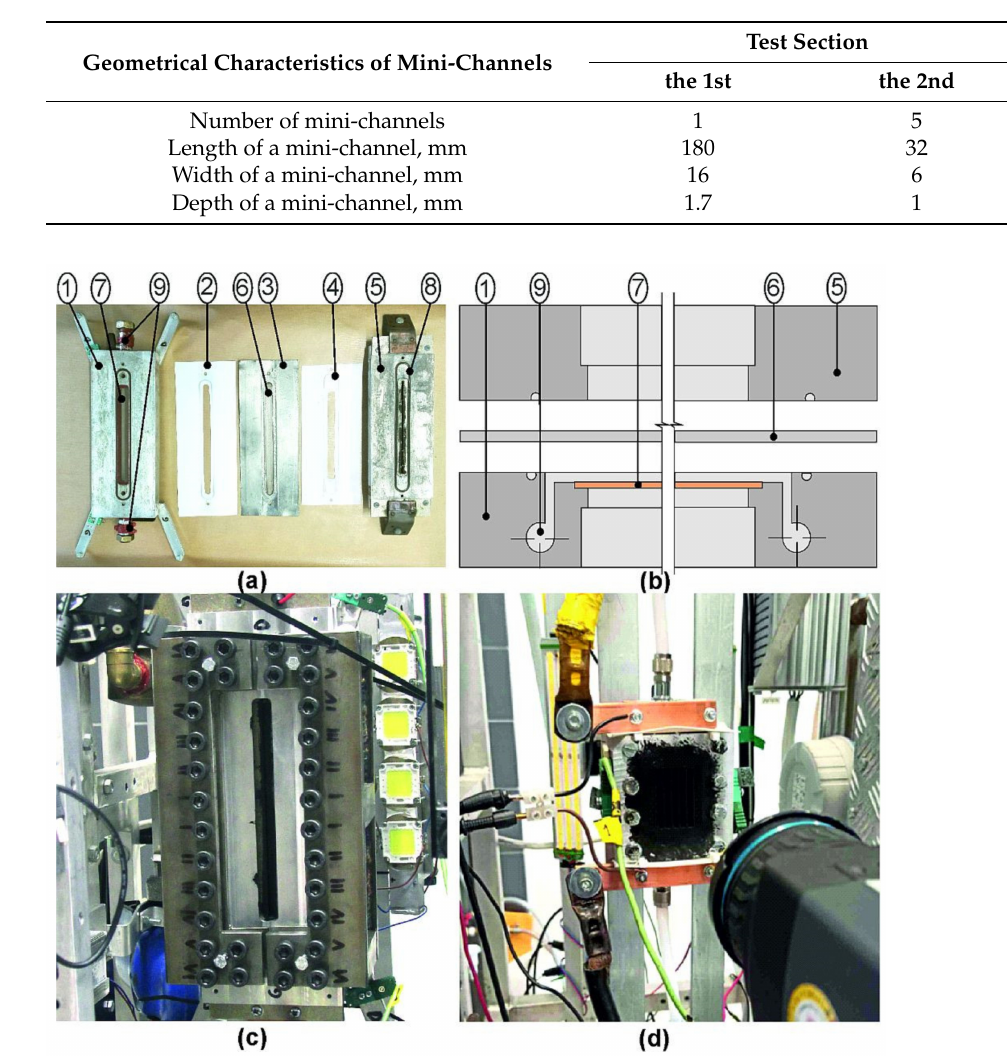
Figure 2. General characteristics of test sections: ( a ) view of the 1st test section components, ( b ) lon- gitudinal section; ( c ) view of the 1st test section; ( d ) view of the 2nd test section; 1—channel body, 2, 4—Teflon plates, 3—graphite plate, 5—front cover, 6—heated plate, 7—glass panel, 8—O-ring, 9—temperature and pressure